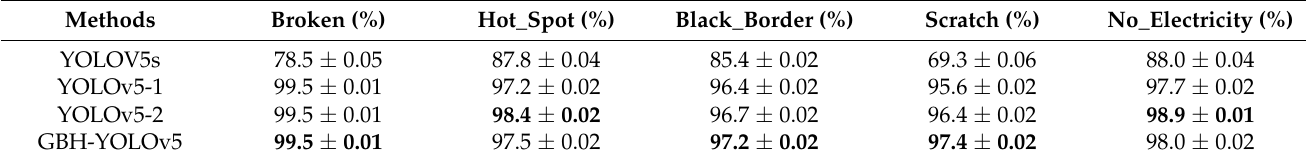
Table 5. Performance comparison of the YOLOv5 model for each category on the test set.